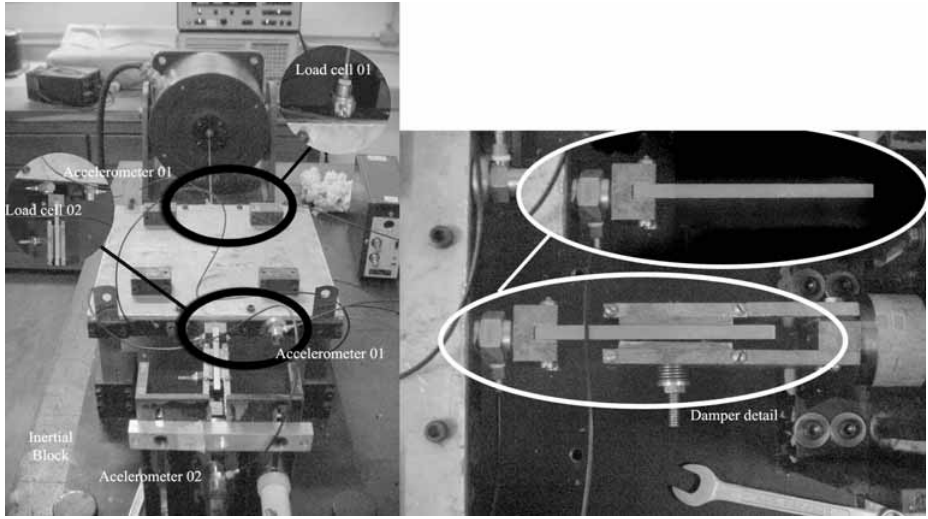
Fig. 8. Single degree of freedon vibratory system experimental set